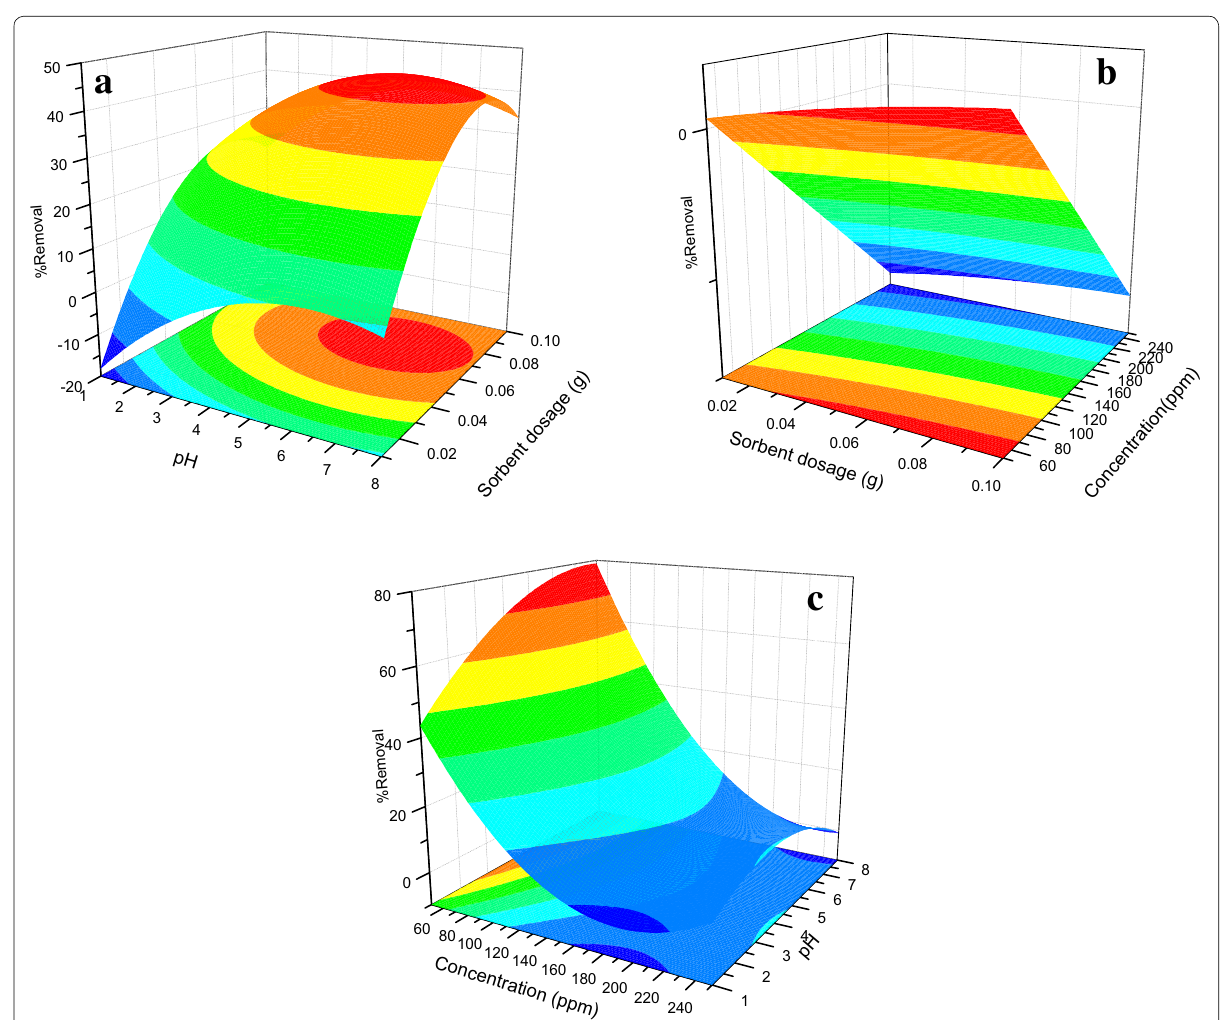
Fig. 10 3D plot to show effect of a pH and sorbent dosage, b sorbent dosage and Cd(II) ion concentration and c pH and Cd(II) ion concentration on the percentage adsorption of Cd(II) ions by orange